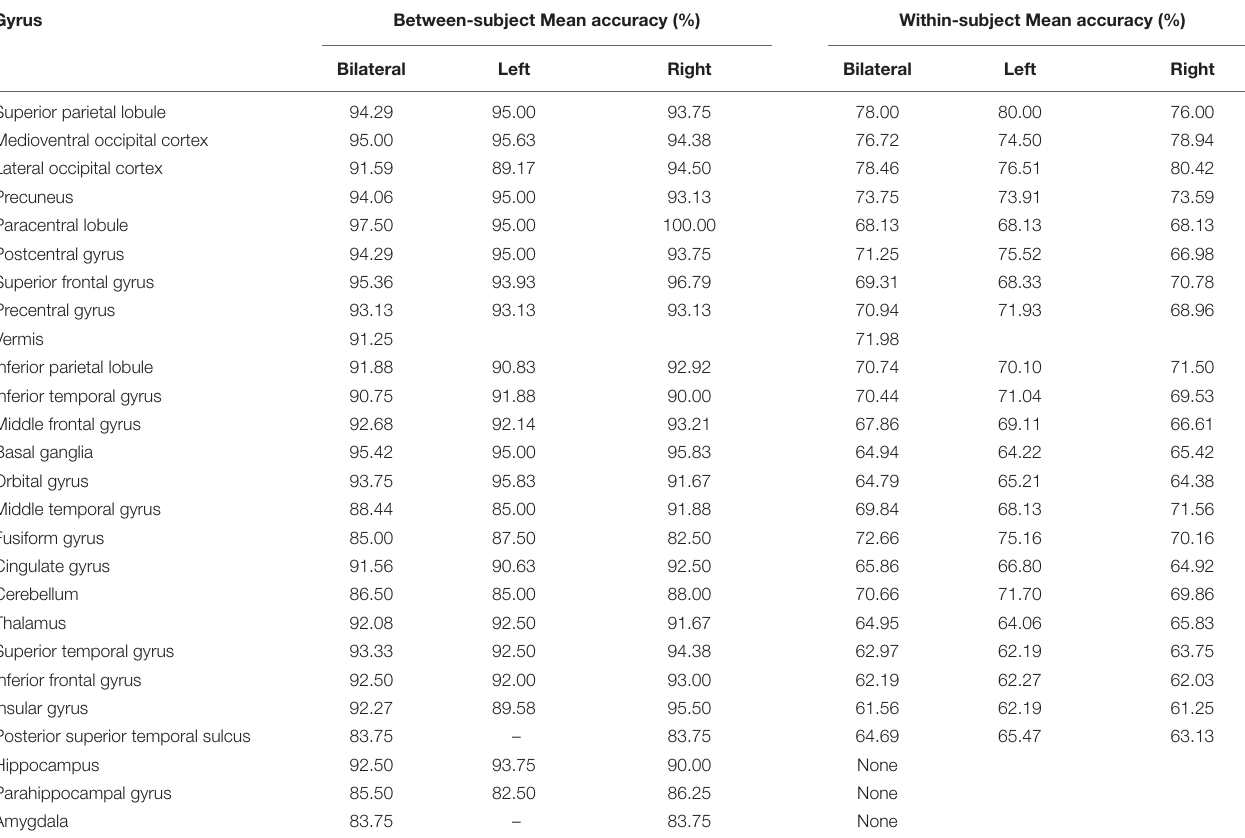
TABLE 2 | Mean accuracy from between-subject and within-subject MVPAs in each corrected region. Gyrus Between-subject Mean accuracy (%) Within-subject Mean accuracy (%) Bilateral Left Right Bilateral Left